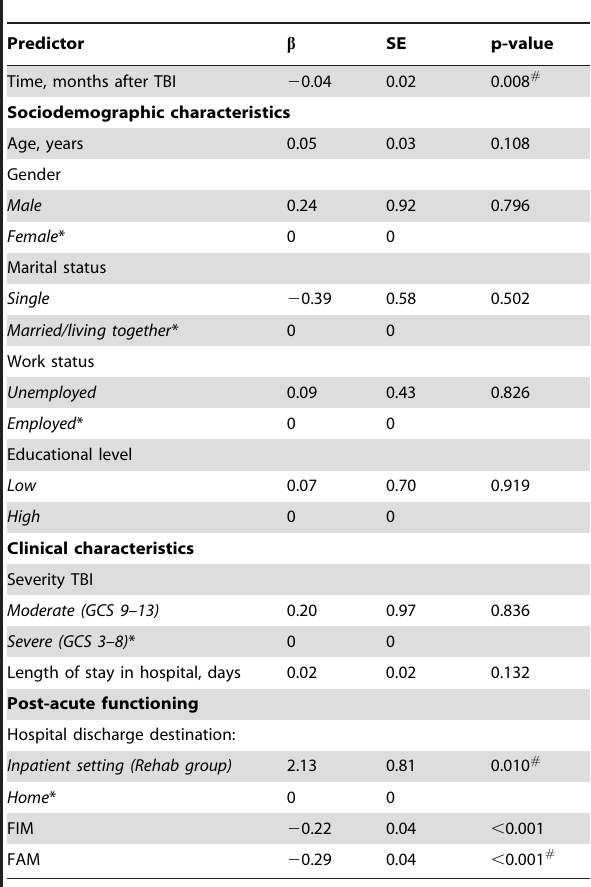
Table 3. Results of the mixed model analysis to predict the course of mood measured with the Wimbledon Self-Report Scale (WSRS) total scores in the home